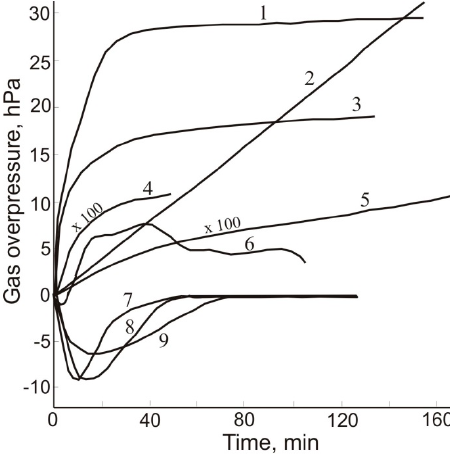
Figure 4. Variations in the free gas overpressure in sealed shot-holes (Karnasurt Mine, Lovozero loparite deposit). Time from a shot-hole drilling until the beginning of measurements: 9 months (1), 8 days (2), and 1 min (3–9). From [19], with minor